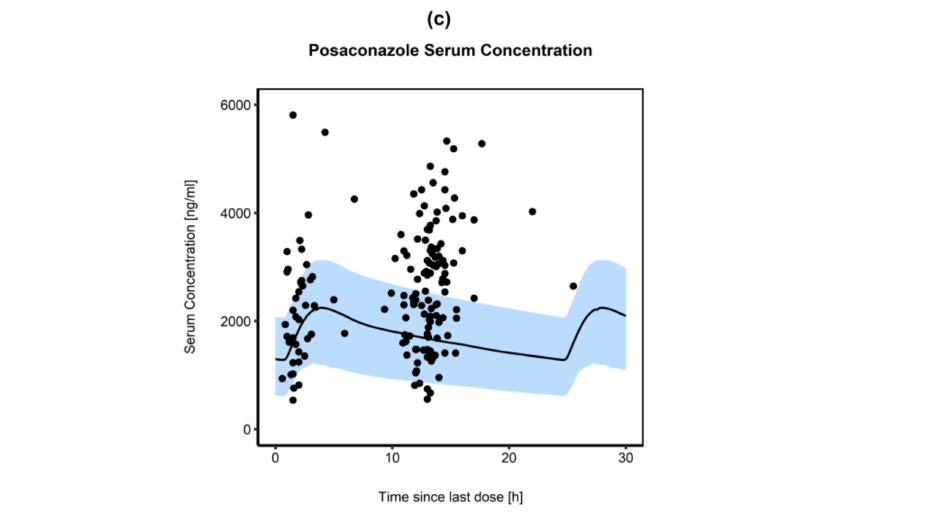
Figure 4. Comparison of simulated RUX serum concentration-time profiles following oral adminis- tration (10 mg BID) if ( a ) co-administered with 300 mg oral POS and ( b ) given without its perpetrator. Observed RUX concentrations are shown as dots with different colors, representing different RUX daily doses actually taken by the patients. Median RUX concentrations are shown as a black line in each part. Part ( c ) represents predicted (black solid line) and observed POS concentrations (black dots) after administration of 300 mg oral POS tablet once daily. The blue shaded areas represent the 5% to 95% prediction intervals for population simulations ( n = 100) of the resulting RUX and POS plasma concentrations,